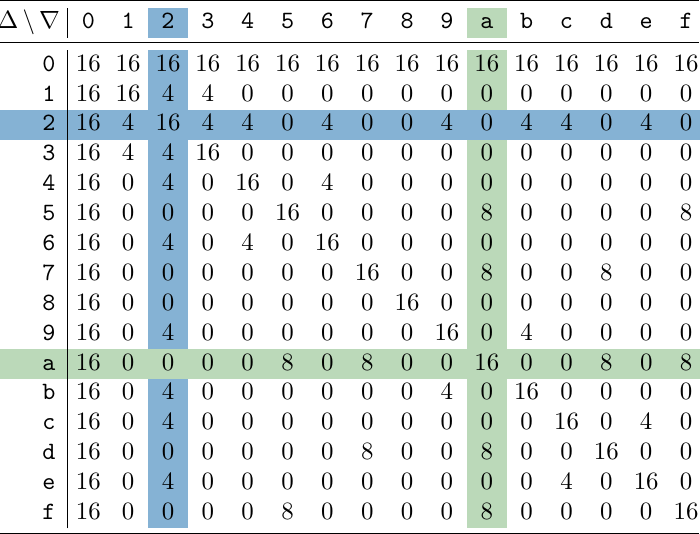
Table 6: FBCT of WARP ’s S-box.